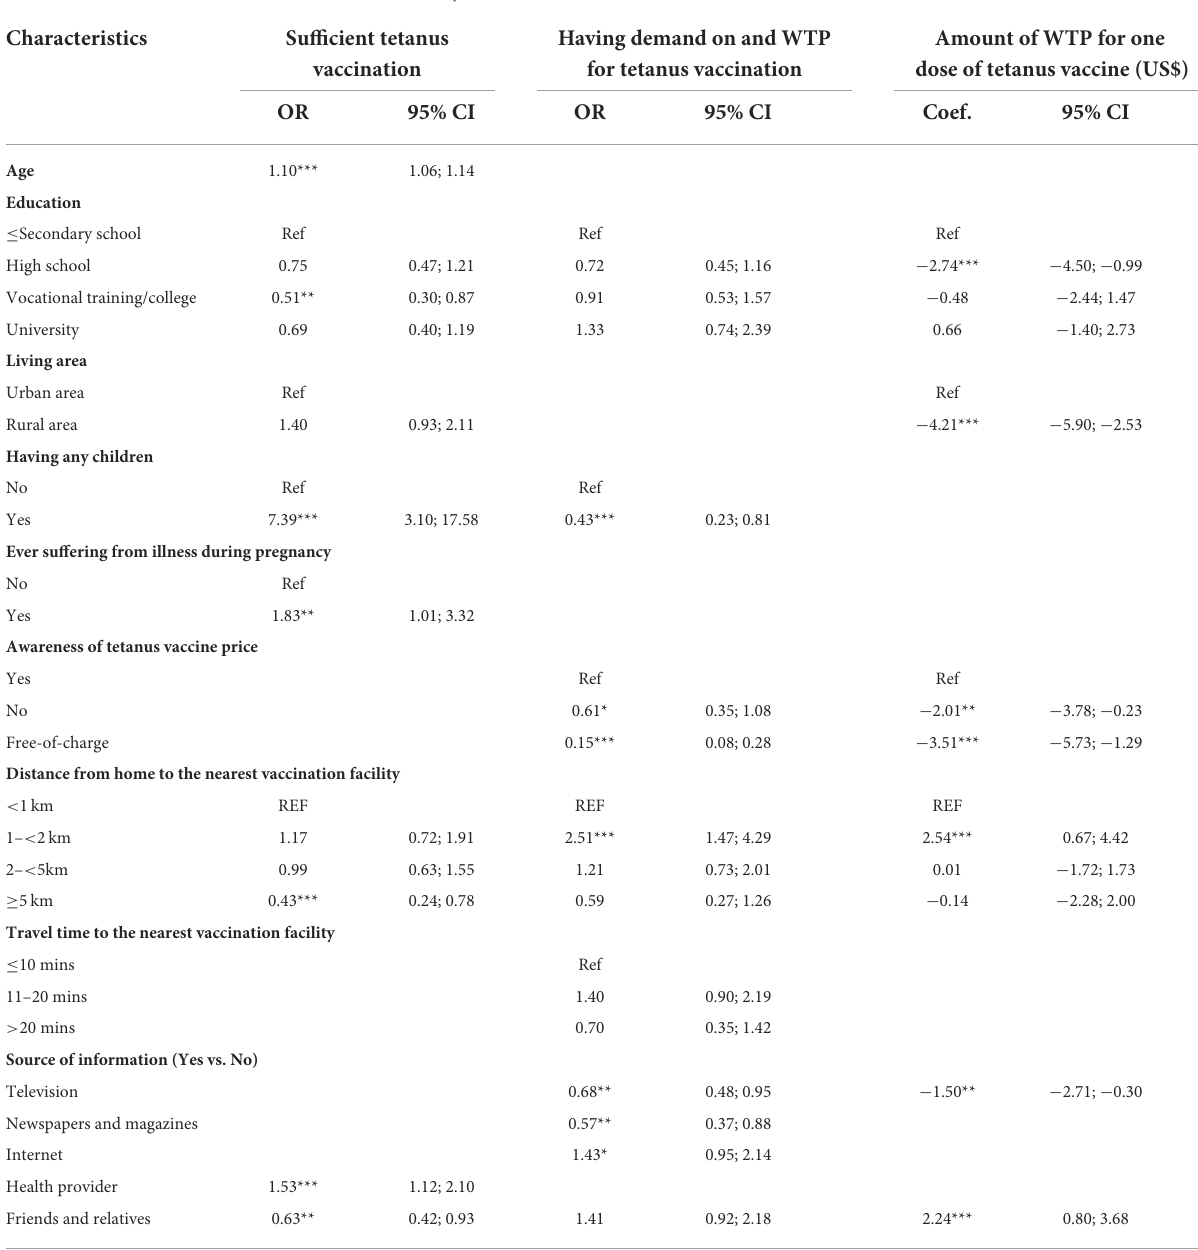
TABLE 4 Associated factors with tetanus vaccination uptake, demand, and WTP. Characteristics Sufficient tetanus Having demand on and WTP Amount of WTP for one vaccination for tetanus vaccination dose of tetanus vaccine (US$)